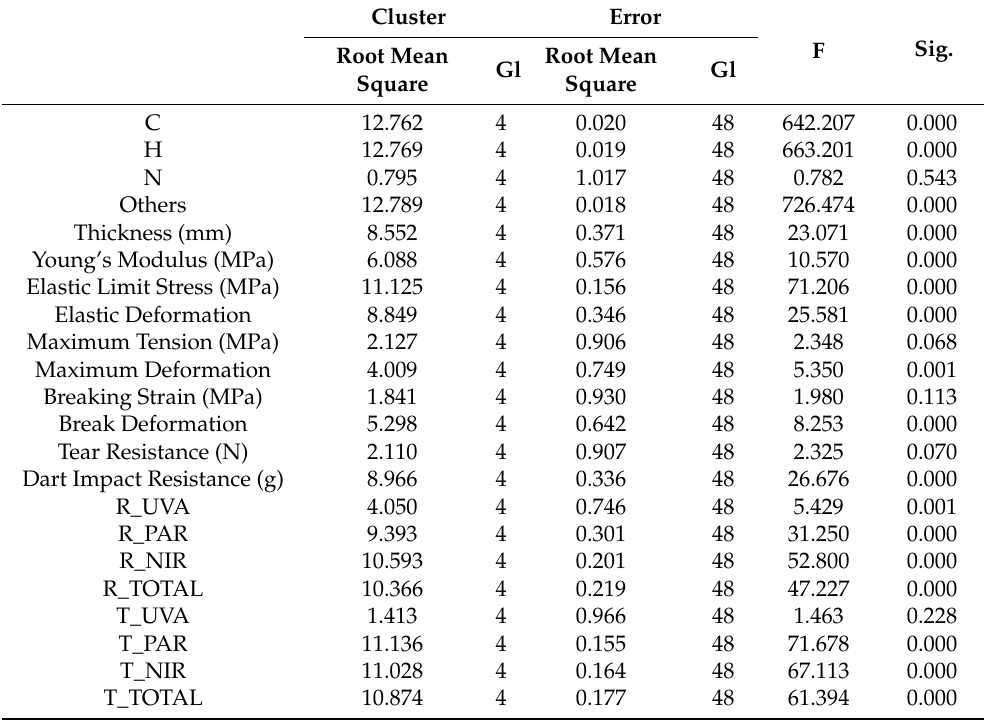
Table 8. Significant variables in group